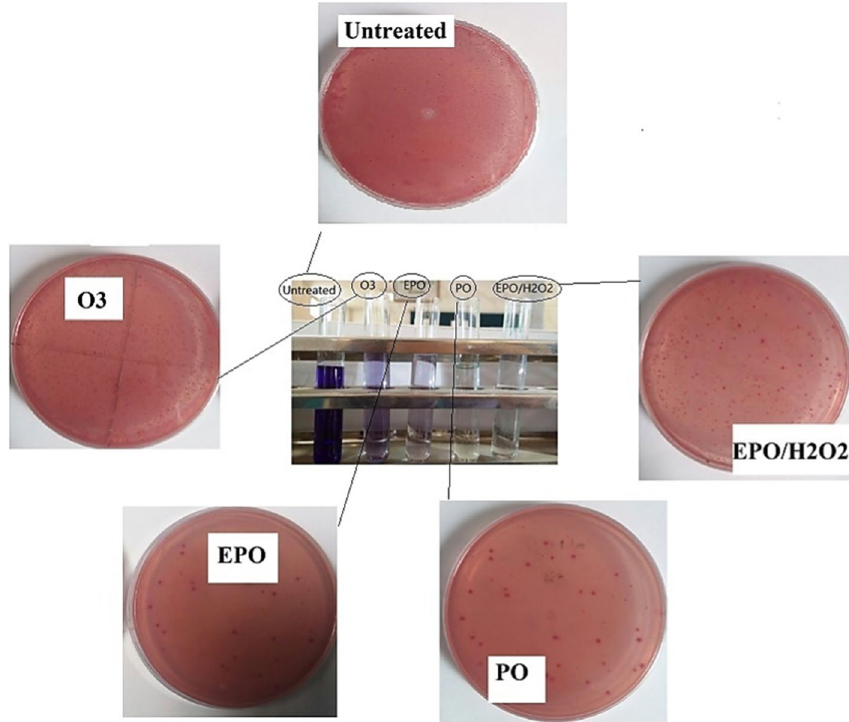
Fig. 8 E. coli growth colonies in the presence of treated waste- water with ozoation, peroxone, e-proxone, and e-proxone/H 2 O